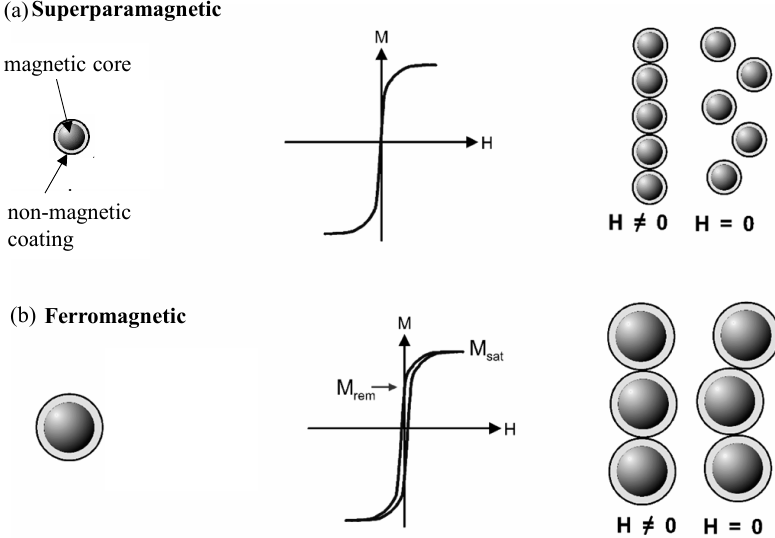
Figure 2. Comparison of superparamagnetic and ferromagnetic particles, from left to right: ( a ) Schematic diagram of a spherical magnetic nanoparticle with a non-magnetic coating ( left ), magnetization loop of an ensemble of nanosize superparamagnetic particles ( center ), and nanoparticle superstructure exposed to a magnetic field H , and decomposition of the superstructure after field removal ( right ). ( b ) Schematic diagram of a spherical magnetic microparticle ( left ), magnetization loop of an ensemble of ferromagnetic particles ( center ), and superstructure in a magnetic field keeping a remnant moment and chain-like superstructure after field removal ( right ) (adapted from [4]).